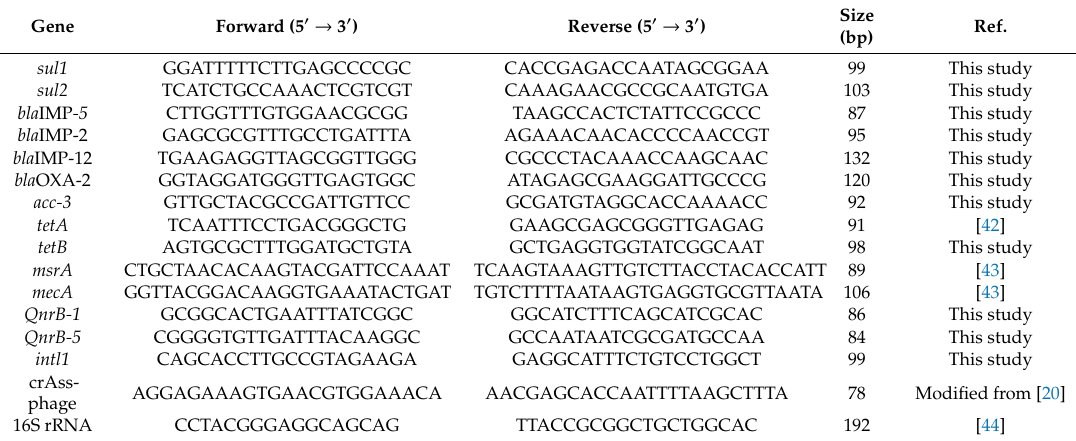
Table 1. Primers used for quantitative polymerse chain reaction (qPCR)